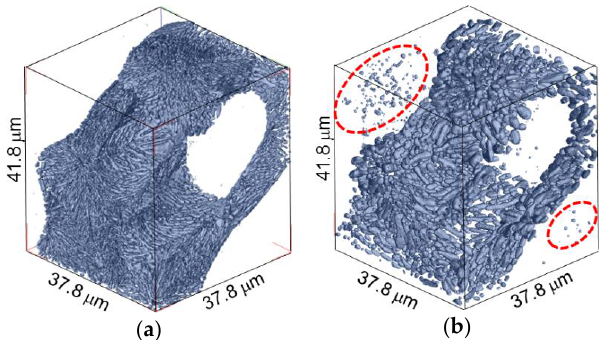
Figure 8. Three-dimensional volume images in Al-10.1%Si-4ppmP-108ppmSr cast alloy; ( a ) as-cast and ( b ) after 7.2 ks heat-treated. New Si-particle precipitate during heat treatment. Figure 9 indicates changes in total Si-particle volume, number of Si-particles and average Si- particle size (sphere-equivalent diameter) during heat treatment. These statistics were obtained from the microstructures shown in Figures 6 and 7 by three-dimensional image processing analysis. The total Si-particle volume in Al-10.1%Si-4ppmP-108ppmSr cast alloy is larger than that in Al-9.8%Si- 3ppmP cast alloy. Volume fraction of Si phase in Al-10%Si alloy should be approximately 11.4%. However, the volume fractions were slightly small in the volumes analyzed and were 7.8% and 8.7% in Al-9.8%Si-3ppmP cast alloy and Al-10.1%Si-4ppmP-108ppmSr cast alloy, respectively. This is due to inhomogeneities of microstructure and the small field of view size in nanotomography. The amount of Si content does not differ in both alloys. The total Si-particle volume in Al-9.8%Si-3ppmP cast alloy looks to slightly decrease during heat treatment. This change is due to particles on the edge of view. Total Si-particle volume is almost constant during heat treatment in both alloys. In the as- cast, the number of Si-particles in Al-10.1%Si-4ppmP-108ppmSr cast alloy is larger than that in Al- 9.8%Si-3ppmP cast alloy. This is because total Si-particle volume is large in Al-10.1%Si-4ppmP- 108ppmSr cast alloy, and the particle size is small as observed in Figure 7. The number of particles decreases in both alloys during heat treatment. In Al-9.8%Si-3ppmP cast alloy, fragmentation of Si-